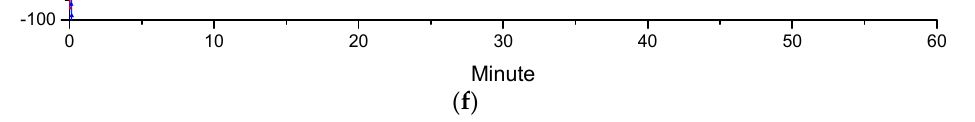
Figure 5. Time series of kinematic PPP positioning errors for BeiDou-3 and BeiDou-3 as well as LEO combined solutions. ( a ) CENT BeiDou-3 only; ( b ) CENT BeiDou-3+LEO; ( c ) POTS BeiDou-3 only; ( d ) POTS BeiDou-3+LEO; ( e ) NTUS BeiDou-3 only; ( f ) NTUS BeiDou-3+LEO. Table 8. PPP precision of both BDS and BDS + LEO after the ambiguity convergence (cm). Station